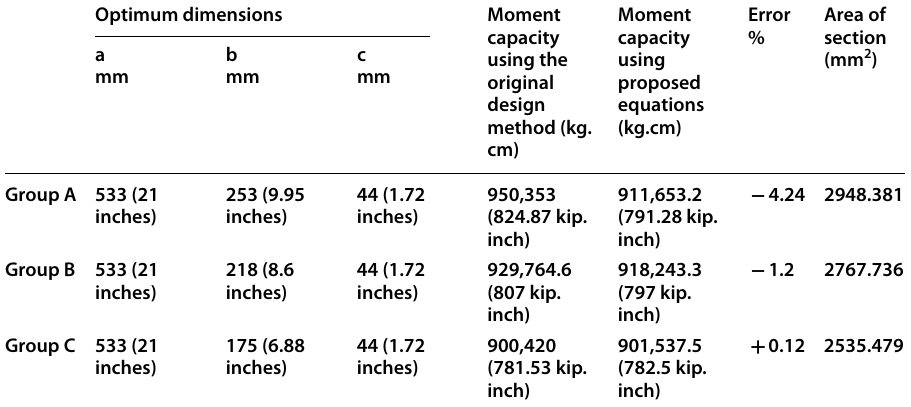
Table 5 Optimization results in the distortional buckling mode using proportions of groups A, B, and C